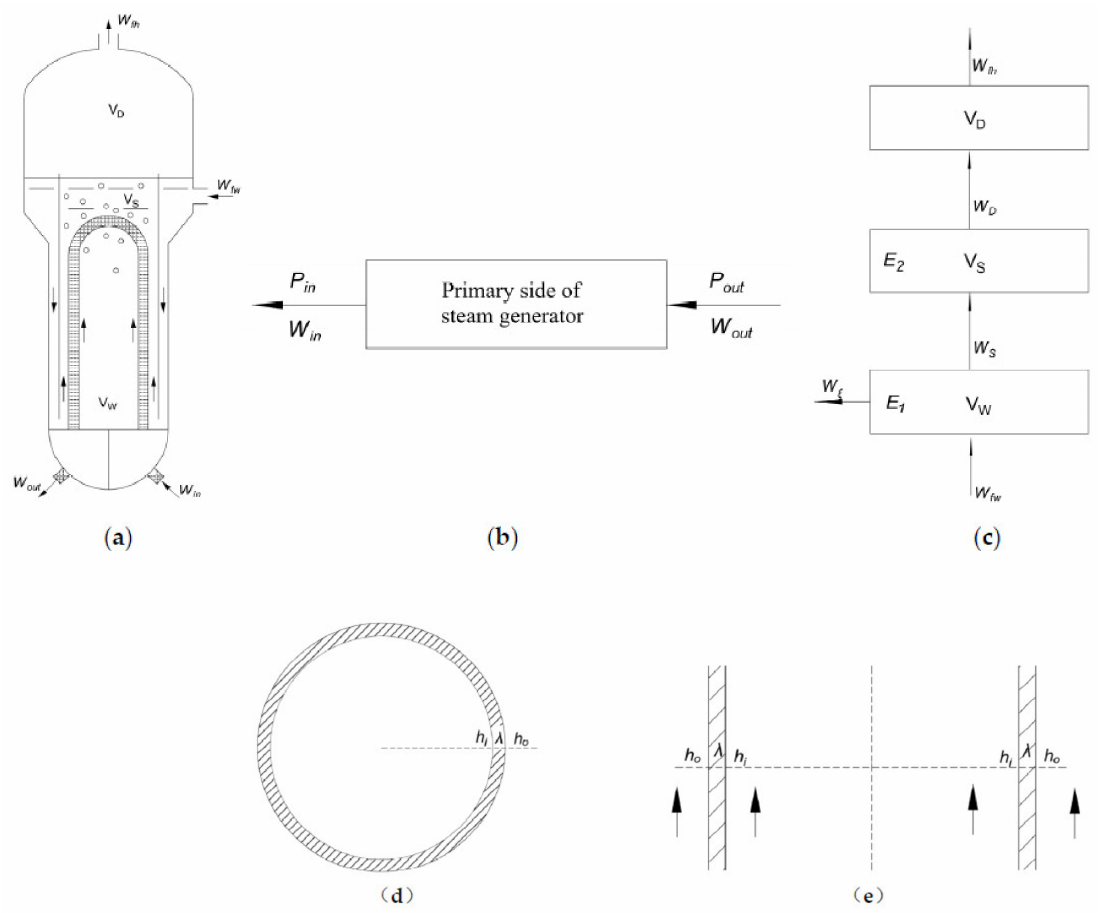
Figure 7. The principle and simplified diagram of the steam generator: ( a ) relationship between energy and mass transfer; ( b ) simplified diagram of the steam generator primary side; ( c ) simpli- fied diagram of the steam generator secondary side; ( d ) cross-section of the steam generator tube; ( e ) longitudinal-section of the steam generator